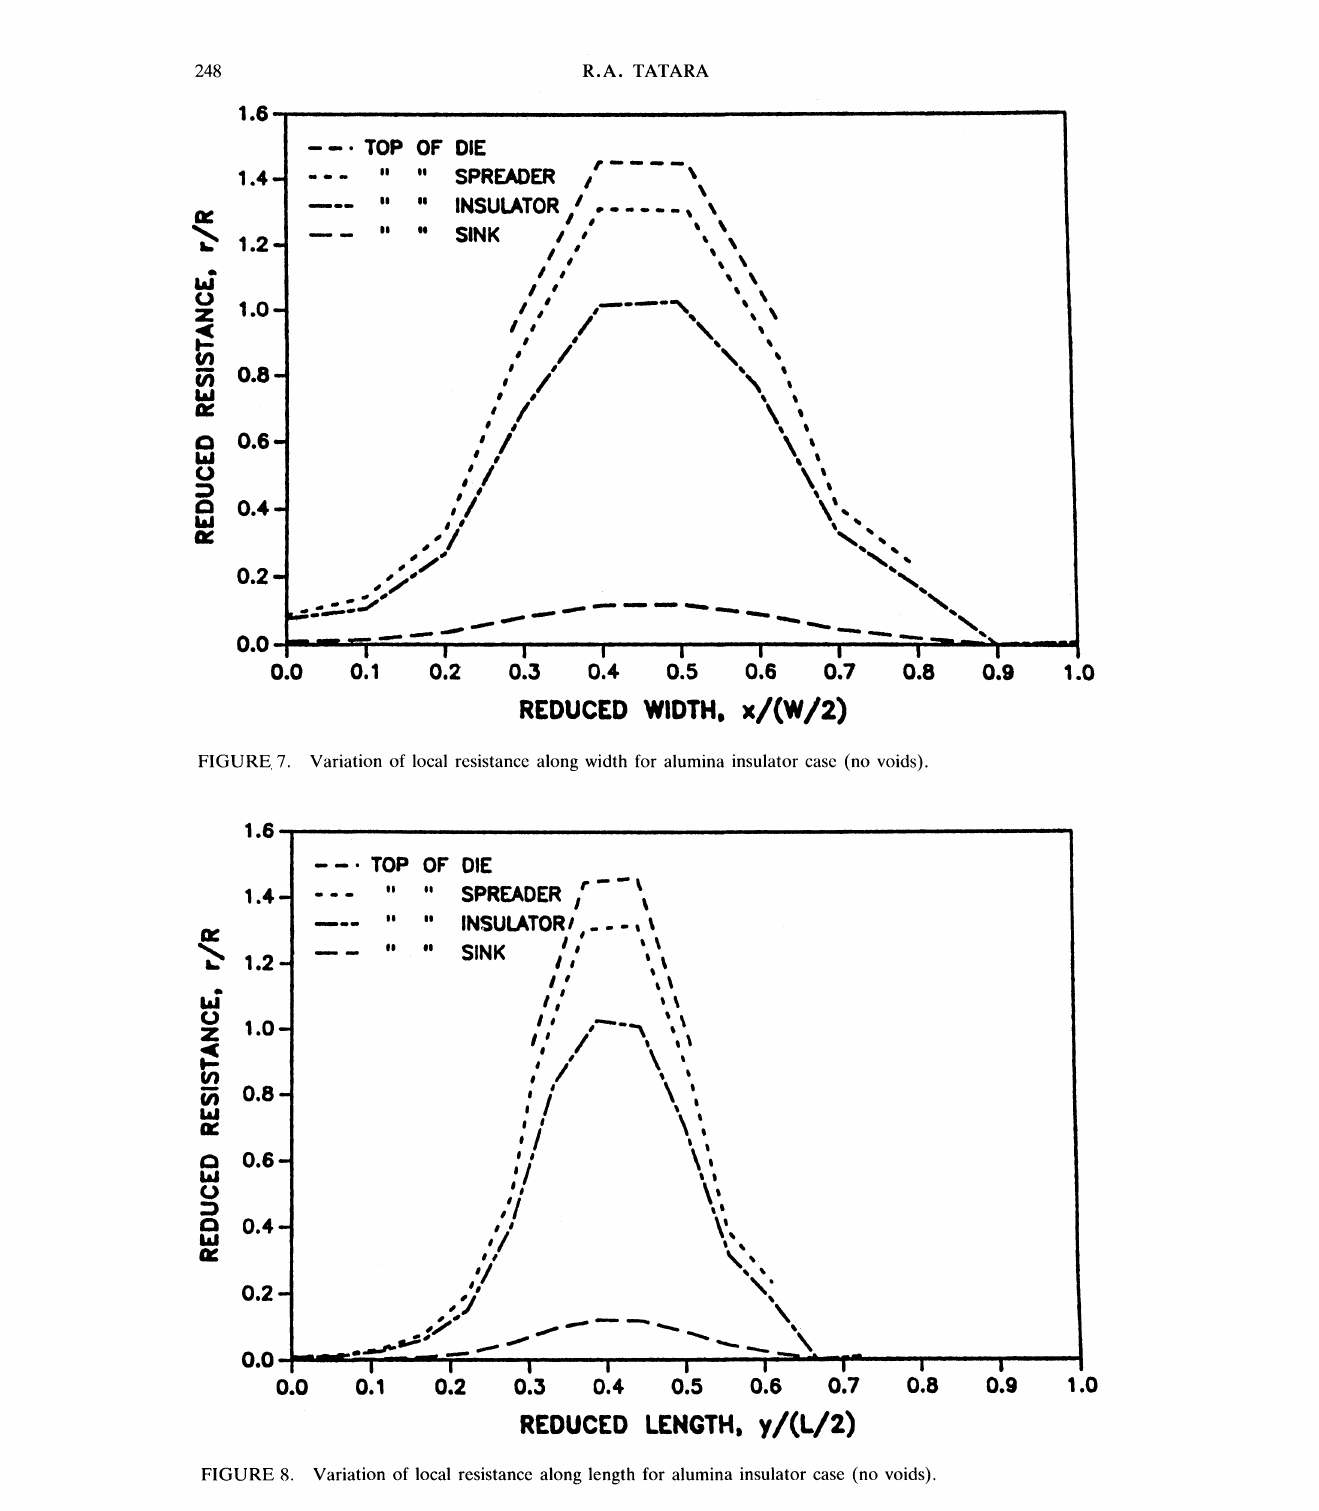
FIGURE 8. Variation of local resistance along length for alumina insulator case (no